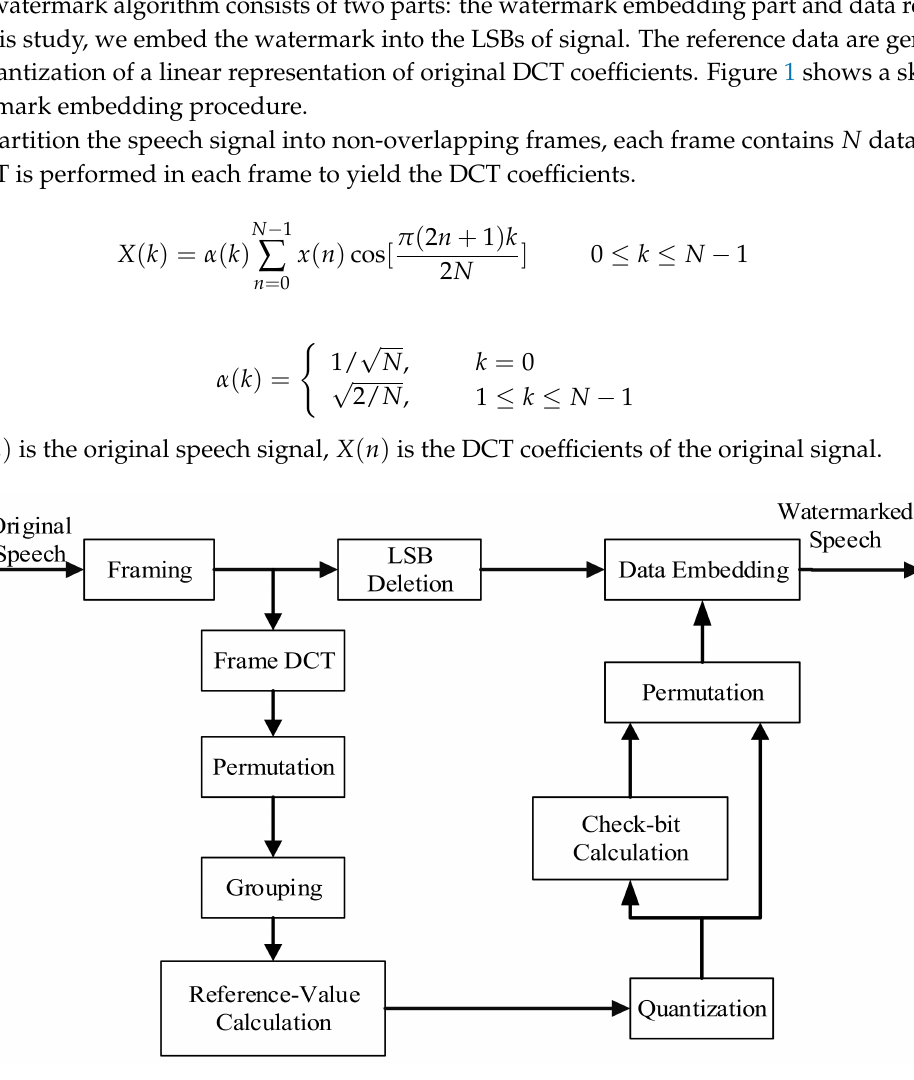
Figure 1. Sketch of watermark embedding